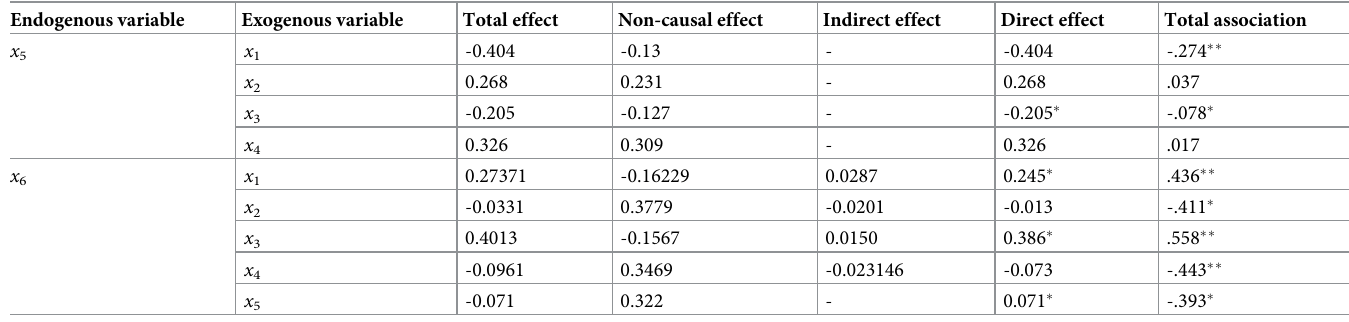
Table 4. Effects of independent variables on